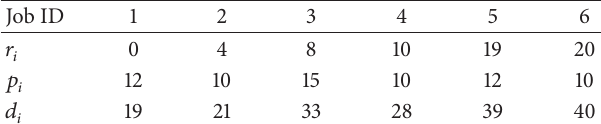
Figure 3: An example for decoding procedure. Table 1: Relevant